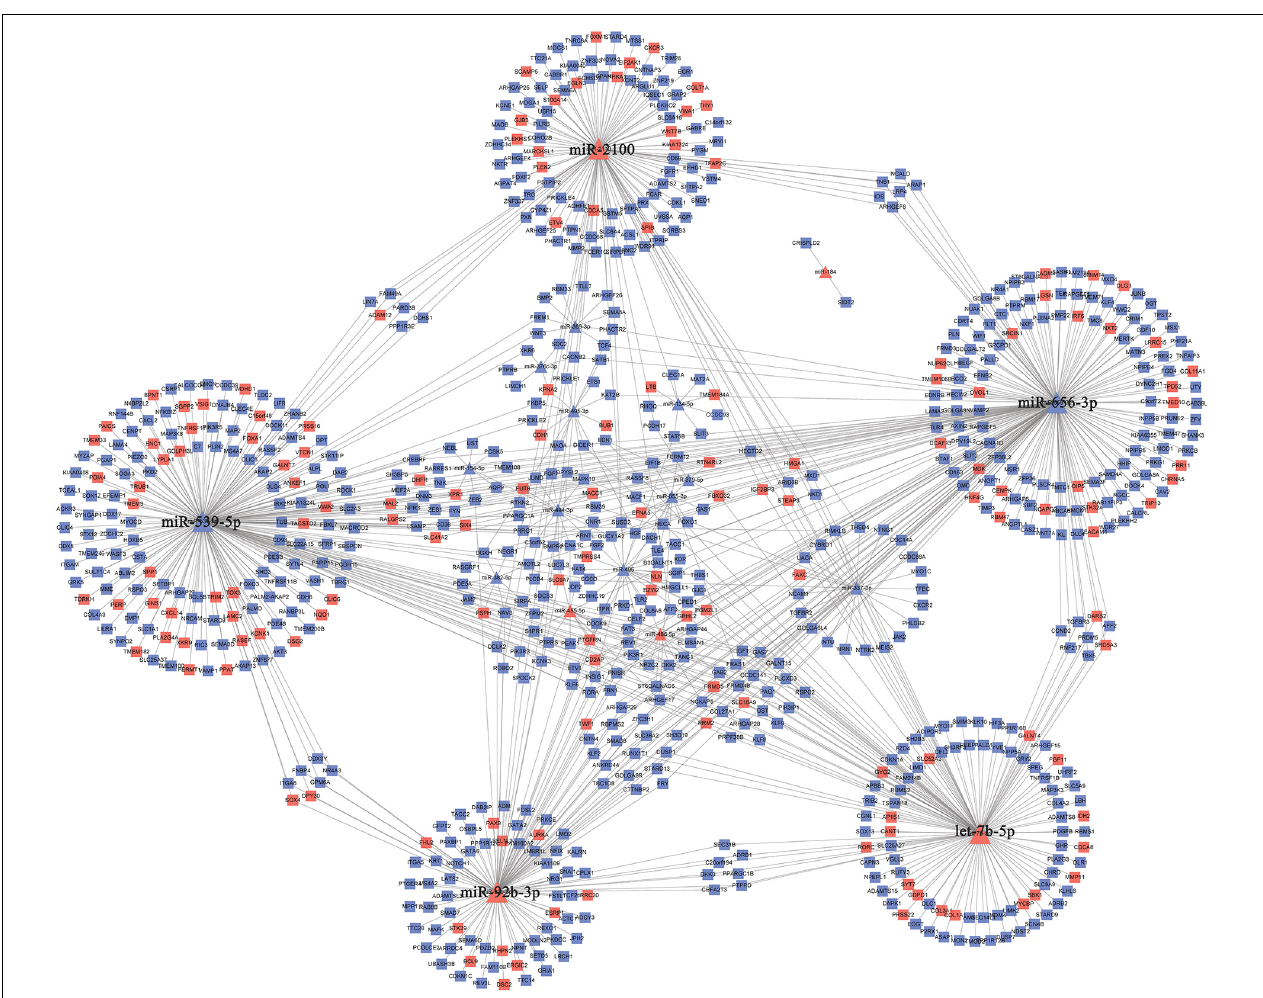
FIGURE 3 | The miRNA–mRNA regulatory network. The rectangles and triangles represent mRNAs and miRNAs, respectively. Red represents the upregulated expression of miRNA or mRNA; blue represents the downregulated expression of miRNA or mRNA. miRNA, microRNA; mRNA, messenger RNA.